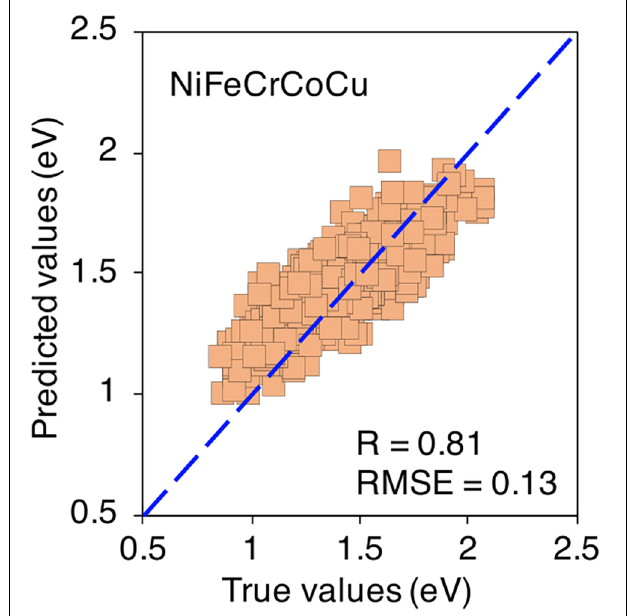
FIGURE 13 | True vs ML predicted formation energies in equi-atomic NiFeCrCoCu alloy.